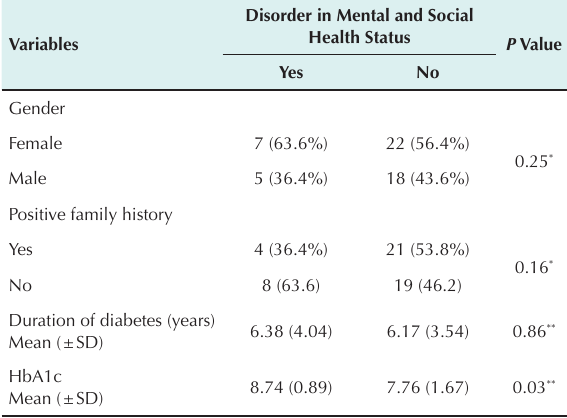
Table 2. Participants’ Characteristics According to Mental and Social Health Status